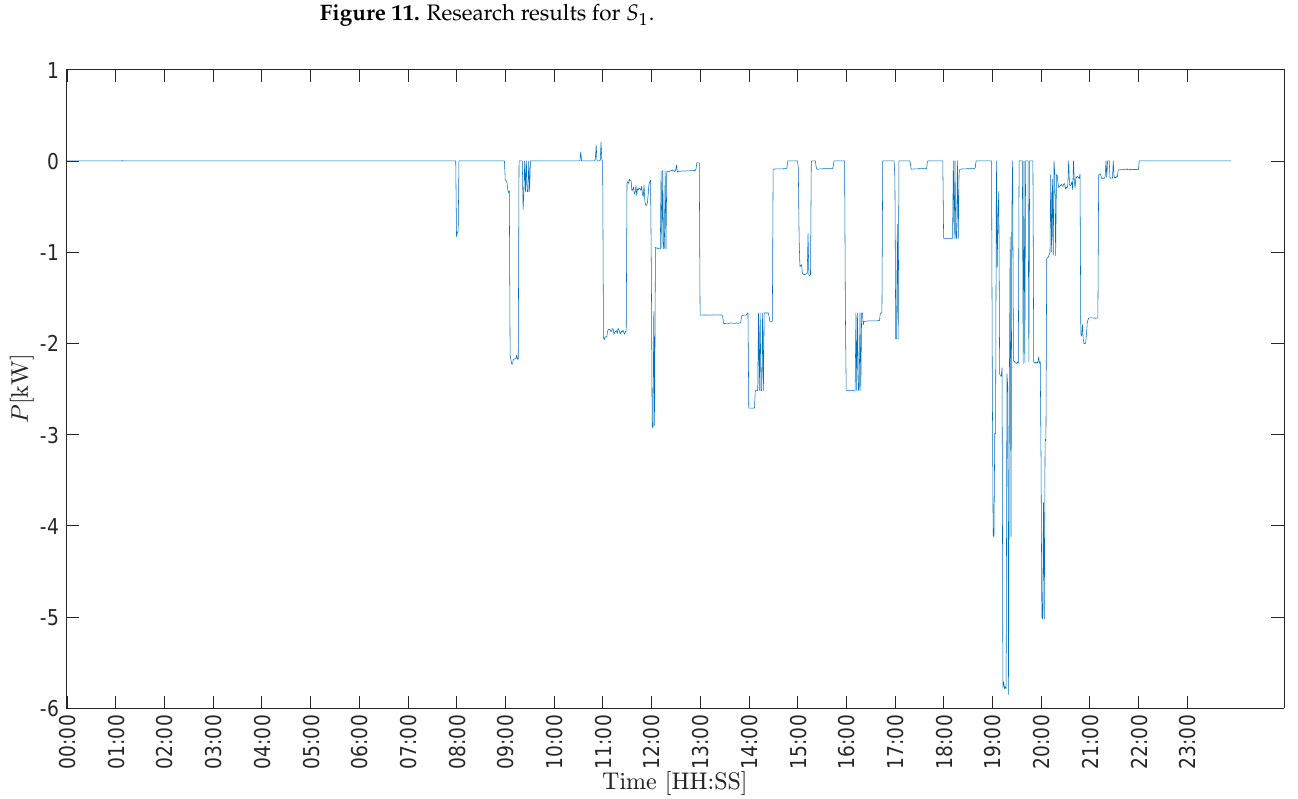
Figure 12. Determining the time when the EEM algorithm worked, based on the difference ∑ P EEM and ∑ P NOM